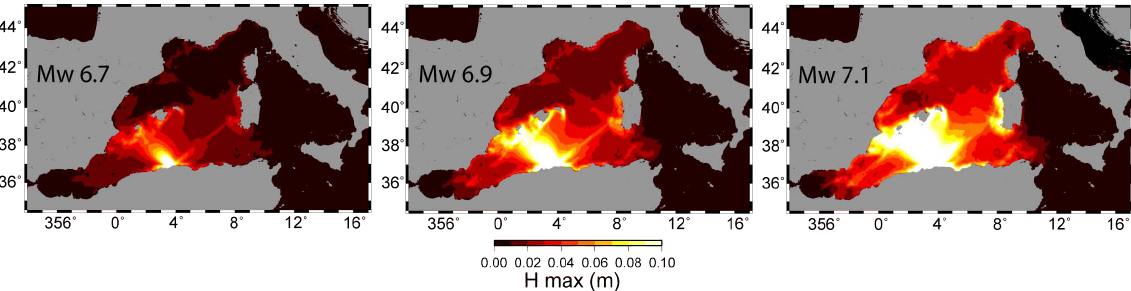
Fig. 6. Maximum wave heights obtained for the three final composite scenarios of the same event, taking into account the uncertainty on the magnitude ( ± 0.2) (after 3h of real time